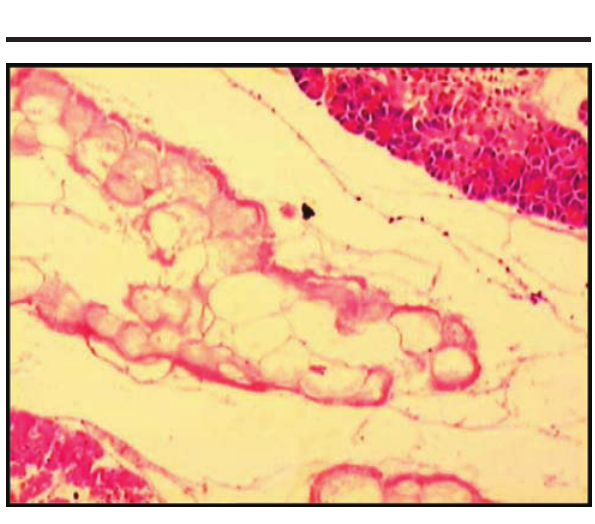
FIGURE 3 - Fotomicrograph.